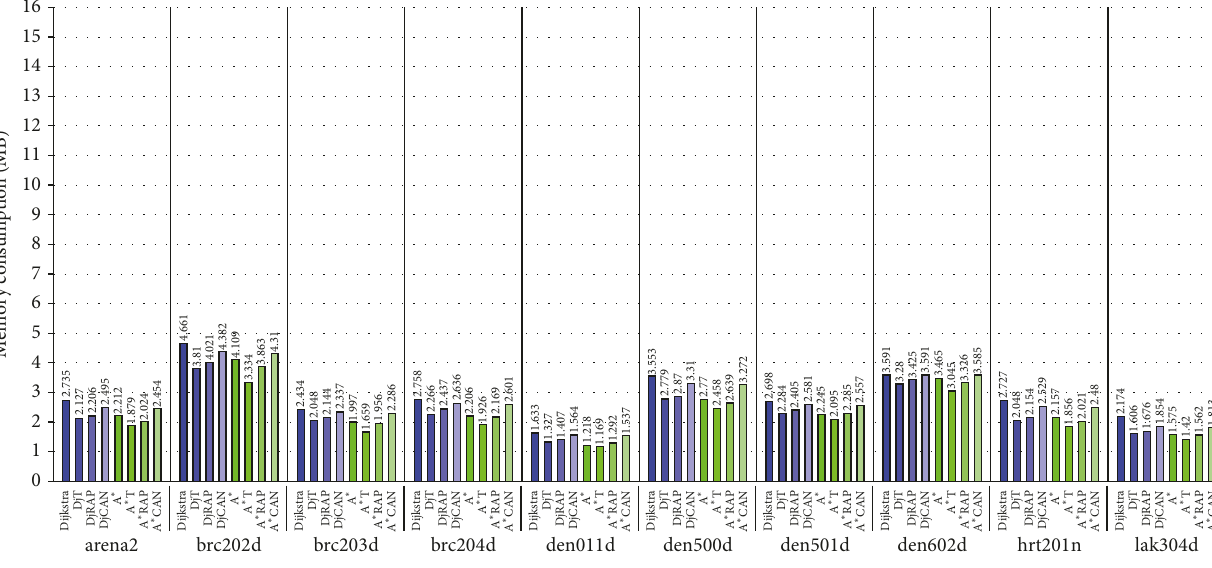
Figure 11: Memory space consumption for 10 maps of Dragon Age: Origins .